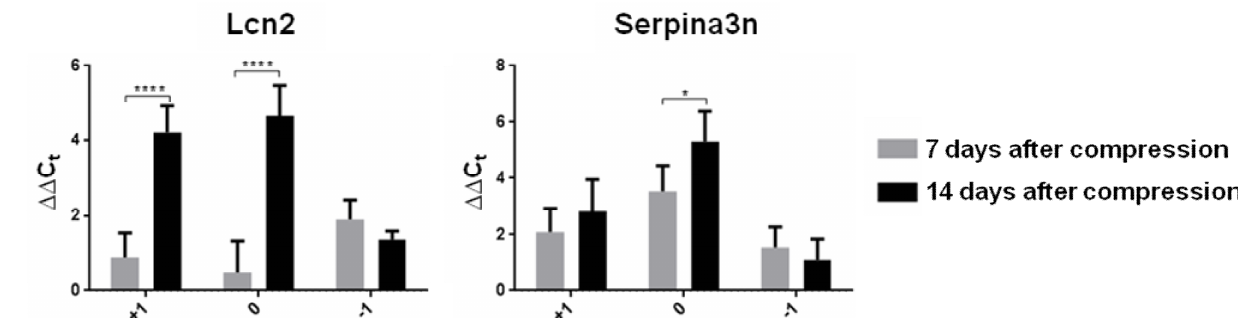
Figure 3. Expression of universal markers (Lcn2 and Serpina3n) for reactive astrocytes in spinal cord segments one and two weeks after Th9 compression. Lcn2 represents the earliest part of the reactive astrogliosis response, and conversely, Serpina3n is a useful marker of more persistent reactive gliosis response. Data are mean values of five experiments ±SD. The mRNA levels for each marker were normalized to the mRNA levels of 18sRNA and expressed as ∆∆ C t values relative to controls. Results were statistically evaluated using unpaired t -test; * p < 0.05; **** p < 0.0001. Lcn2—Lipocalin 2; Serpina3n—Serine (or cysteine) peptidase inhibitor.